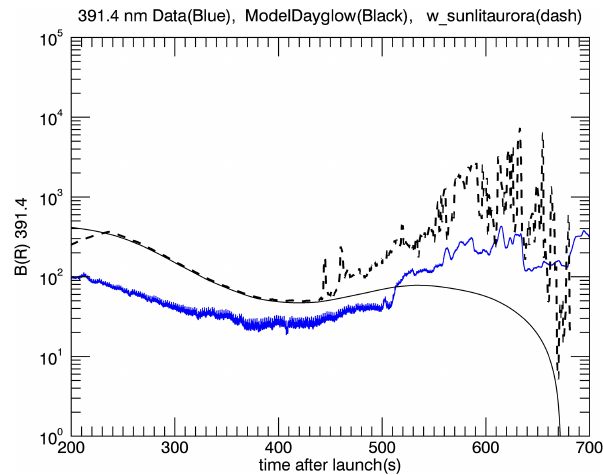
Figure 6. A plot of the brightness in rayleigh of the emission from the ( 0 , 0 ) band of the N 2 + 1NG system at 391.4nm from the RENU2 blue photometer (blue line) vs. time after launch. Also shown are the Strickland model predictions (see text) for the N 2 + 1NG system at 391.4nm dayglow (solid line) and for the N 2 + 1NG system at 391.4nm dayglow plus the N 2 + 1NG system at 391.4nm emission due to the auroral precipitation (dashed line). A time af- ter launch of 200s corresponds to 07:37:30UTC while 700s corre- sponds to